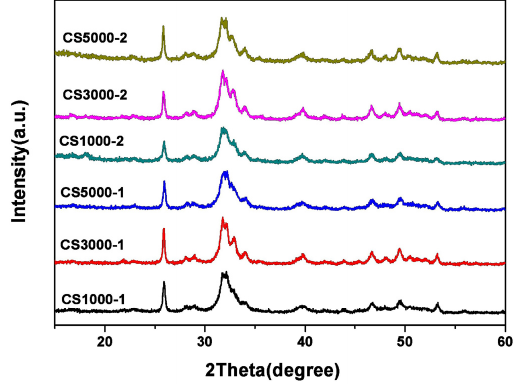
Figure 3. XRD patterns of as-prepared HA samples under different conditions.